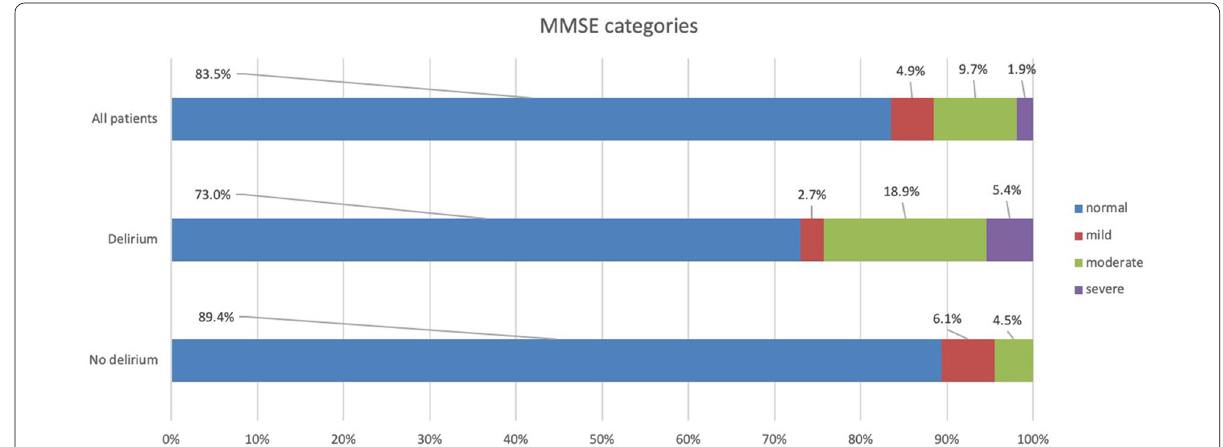
Fig. 2 Frequency distribution of MMSE categories at ICU discharge in all patients, and in patients with and without delirium during ICU